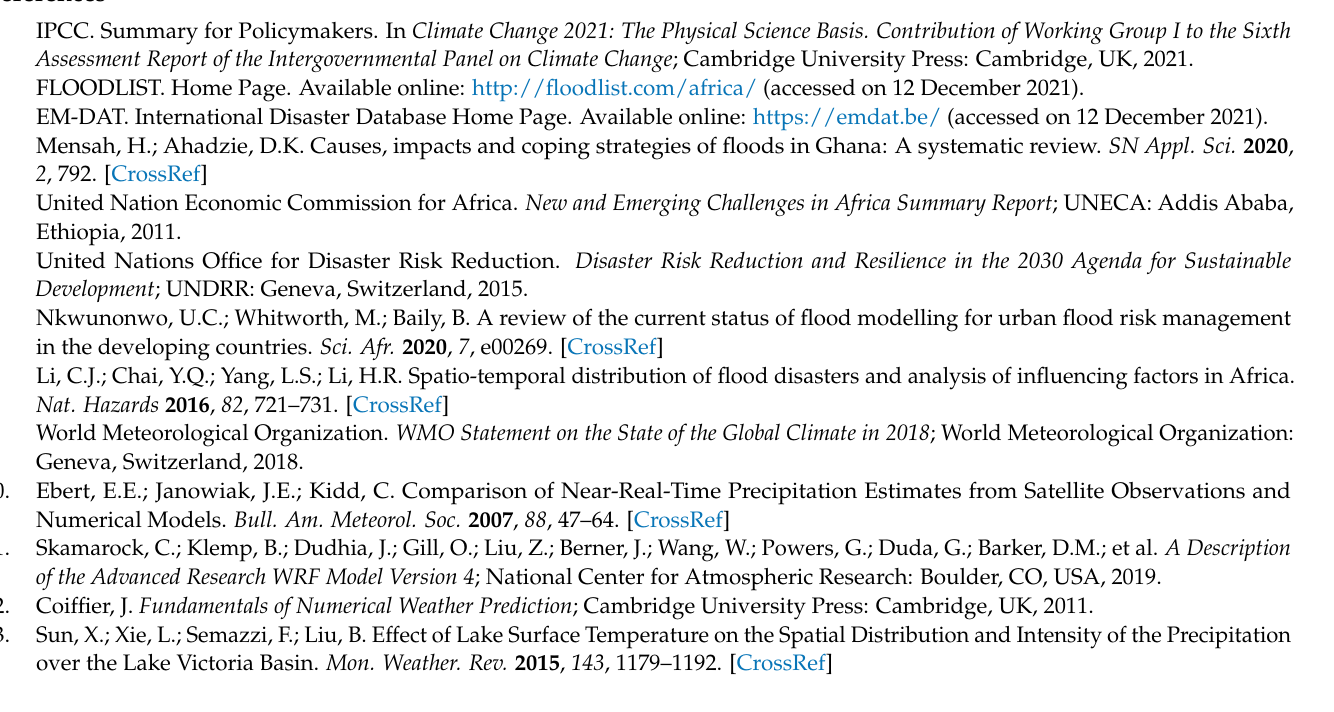
and elevations. Table S2. K-index values for the probability of heavy PRE. Table S3. TTs values for the potential for heavy PRE. Figure S1. Observed and satellite estimated monthly PRE annual cycle over Kenya at sampled stations. Figure S2. Observation and satellite estimate of the average rainfall quantities above the 95th percentile over Kenya; (a) OBSERVATION, (b) CHIRPS, (c) GPM- IMERG, (d) PERSIANN-CCS-CDR, and (e) TAMSAT. Figure S3. Same as Figure S2 but above the 99th percentile. Figure S4. Same as Figure S2 but above R20mm. Figure S5. Distribution of simulated and observed precipitation (mm/d) on 1 September 2020 over East Africa; (a) WRF and (b) PERSIANN- CCS-CDR. Figure S6. Same as Figure S5 but for 6 September